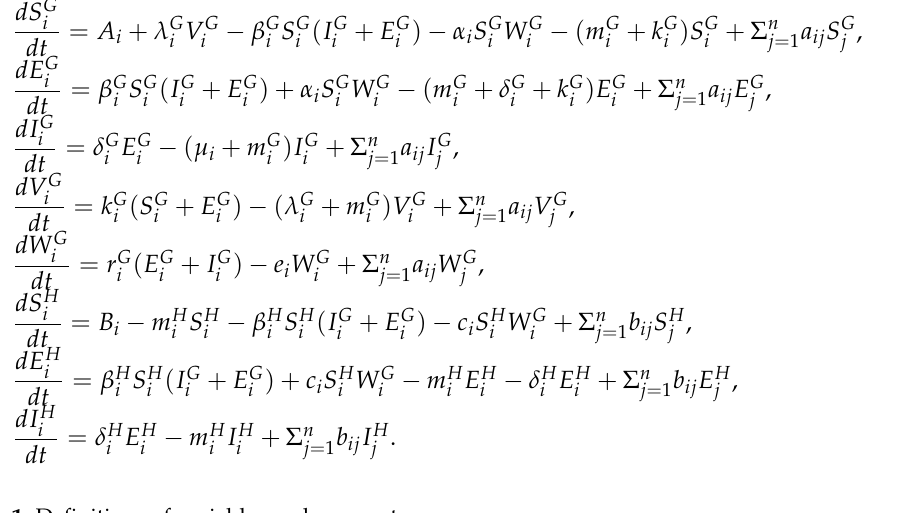
Table 1. Definitions of variables and